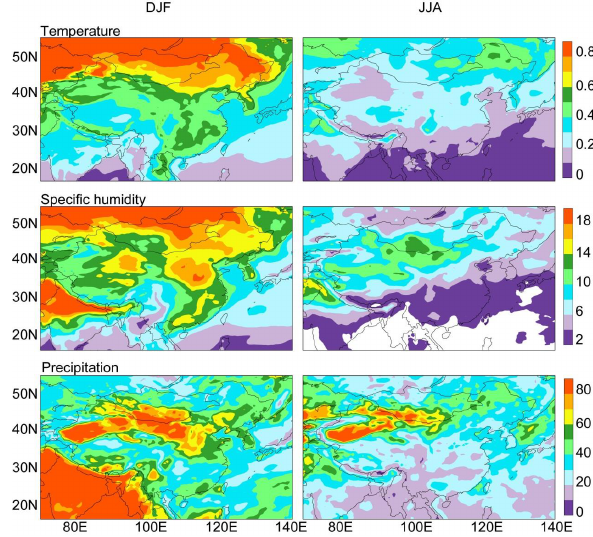
Figure 8. The APDM values (%) of surface air temperature, spe- cific humidity, and precipitation in DJF and JJA based on the GEOS-5 assimilated meteorological fields of